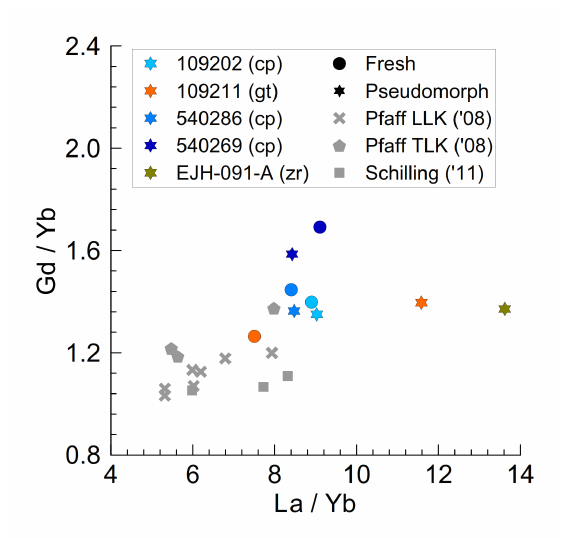
Figure 5. Rare earth element ratios of eudialyte and their pseudomorphs plotted against Laser Ablation ICPMS data for eudialyte from Pfaff et al. [50] and Schilling et al. [18].